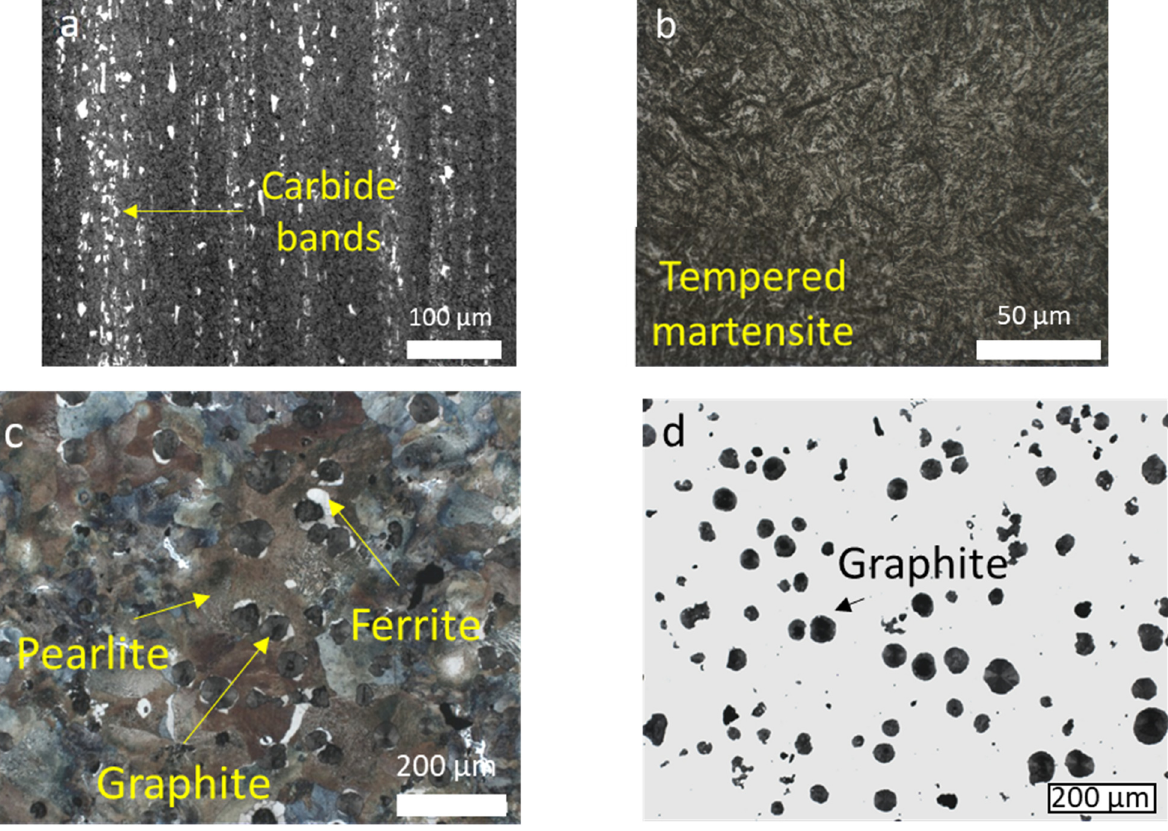
Figure 1. Microstructure of the three tool material batches employed for this study, ( a ) 1.2379 steel deep etched to reveal carbide bands, ( b ) QRO90 steel etched to reveal the tempered martensite, ( c ) GJS-700-2L cast iron etched to reveal the ferrite to pearlite ratio, and ( d ) GJS-700-2L iron as-polished to reveal graphite distribution.